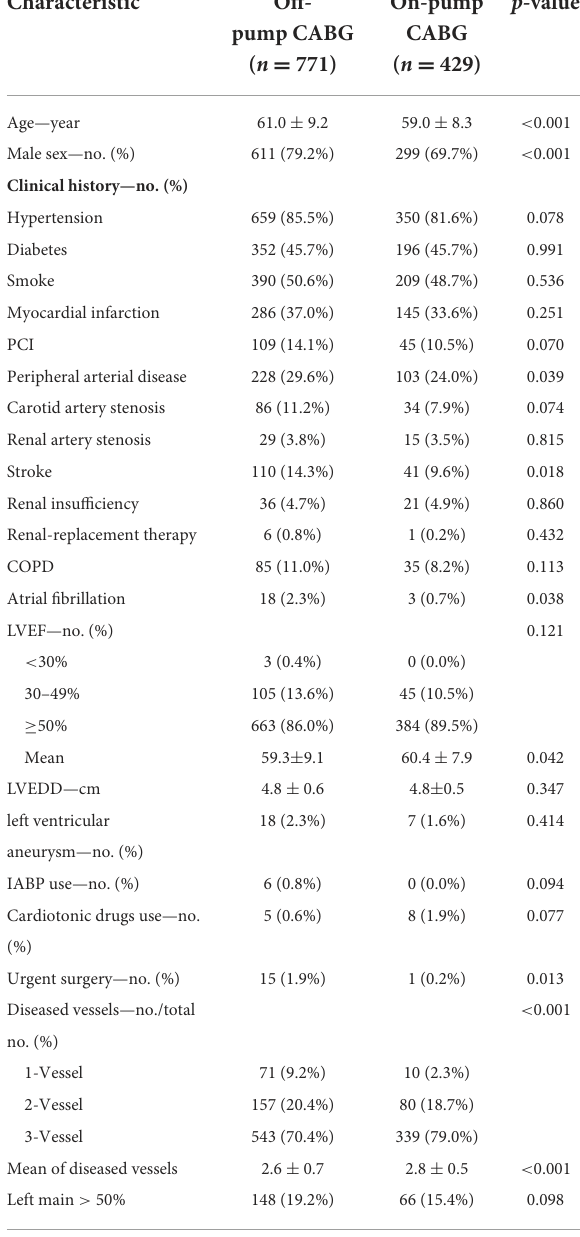
TABLE 1 Baseline characteristics of the patients before